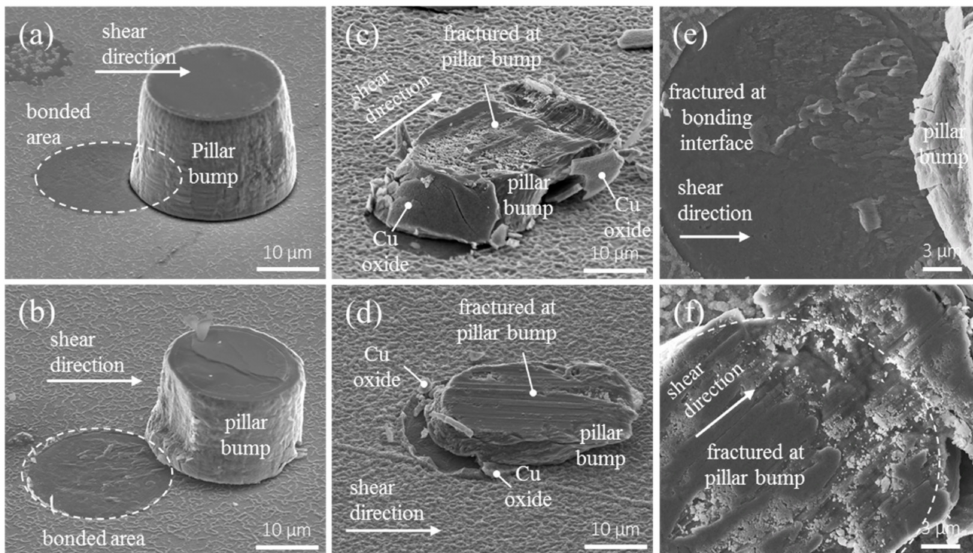
Figure 5. SEM images showing the fractures for the Cu joints bonded at ( a ) 200 ◦ C/100 ◦ C, ( b ) 250 ◦ C/100 ◦ C, ( c ) 300 ◦ C/100 ◦ C, and ( d ) 350 ◦ C/100 ◦ C. ( e ) Enlarged plan-view image for the fracture surface in (b). Brittle fracture occurred for the joints bonded at low temperature below 250 ◦ C/100 ◦ C, and ( f ) enlarged plan-view image for the fracture surface in (c). Ductile fracture took place above 300 ◦ C/100 ◦